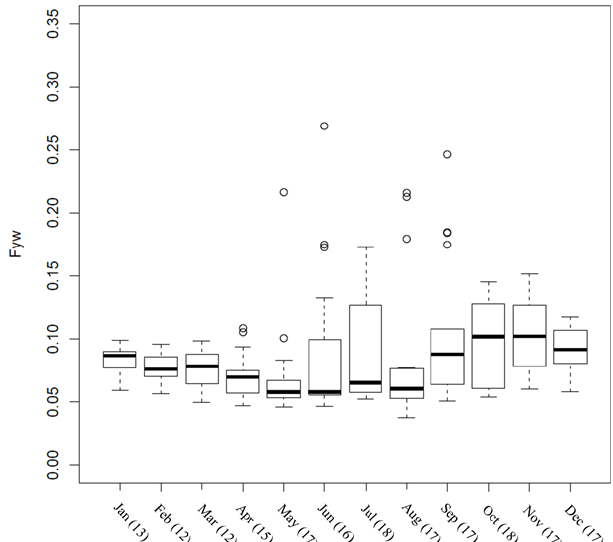
Figure 7. Fyw(189) plotted against hydrometric data (red and black dots): (a) throughfall volumes, (b) runoff volumes, (c) snow height, and (d) the runoff coefficient. Red dots are data points where hy- pothesis 2 was rejected (Fyw does not differ by more than ± 0 . 04 within 4 consecutive weeks).